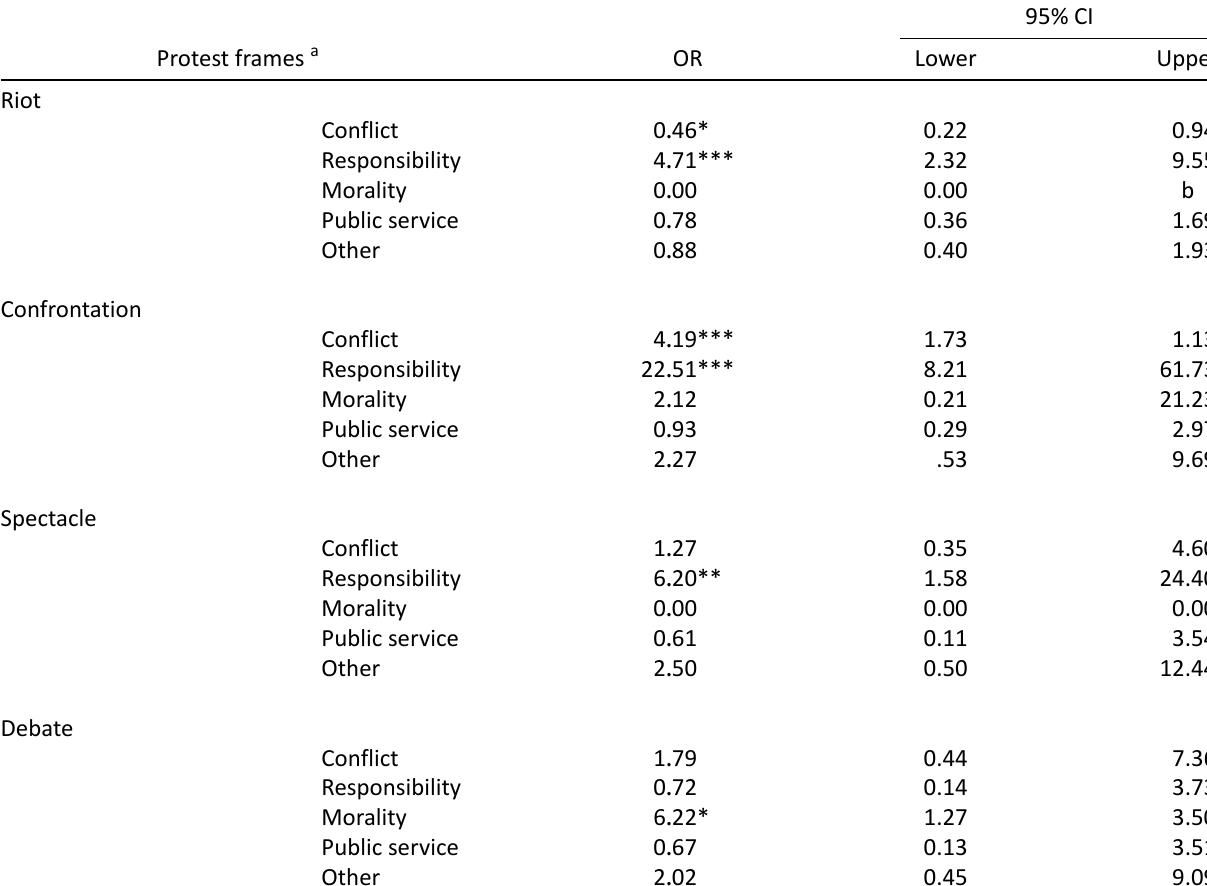
Table 2. Multinomial logistic regression to explain protest